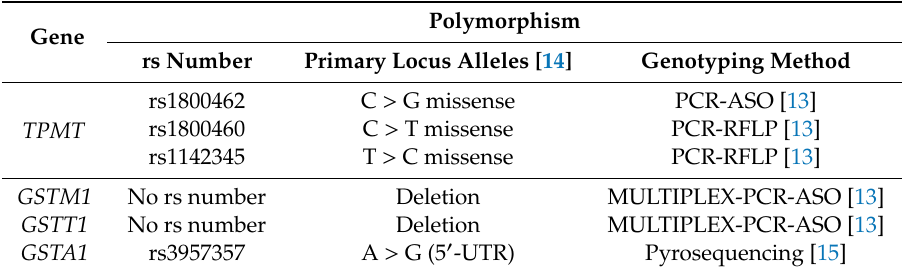
Table 1. Assay used for genotyping of the considered variants. Gene